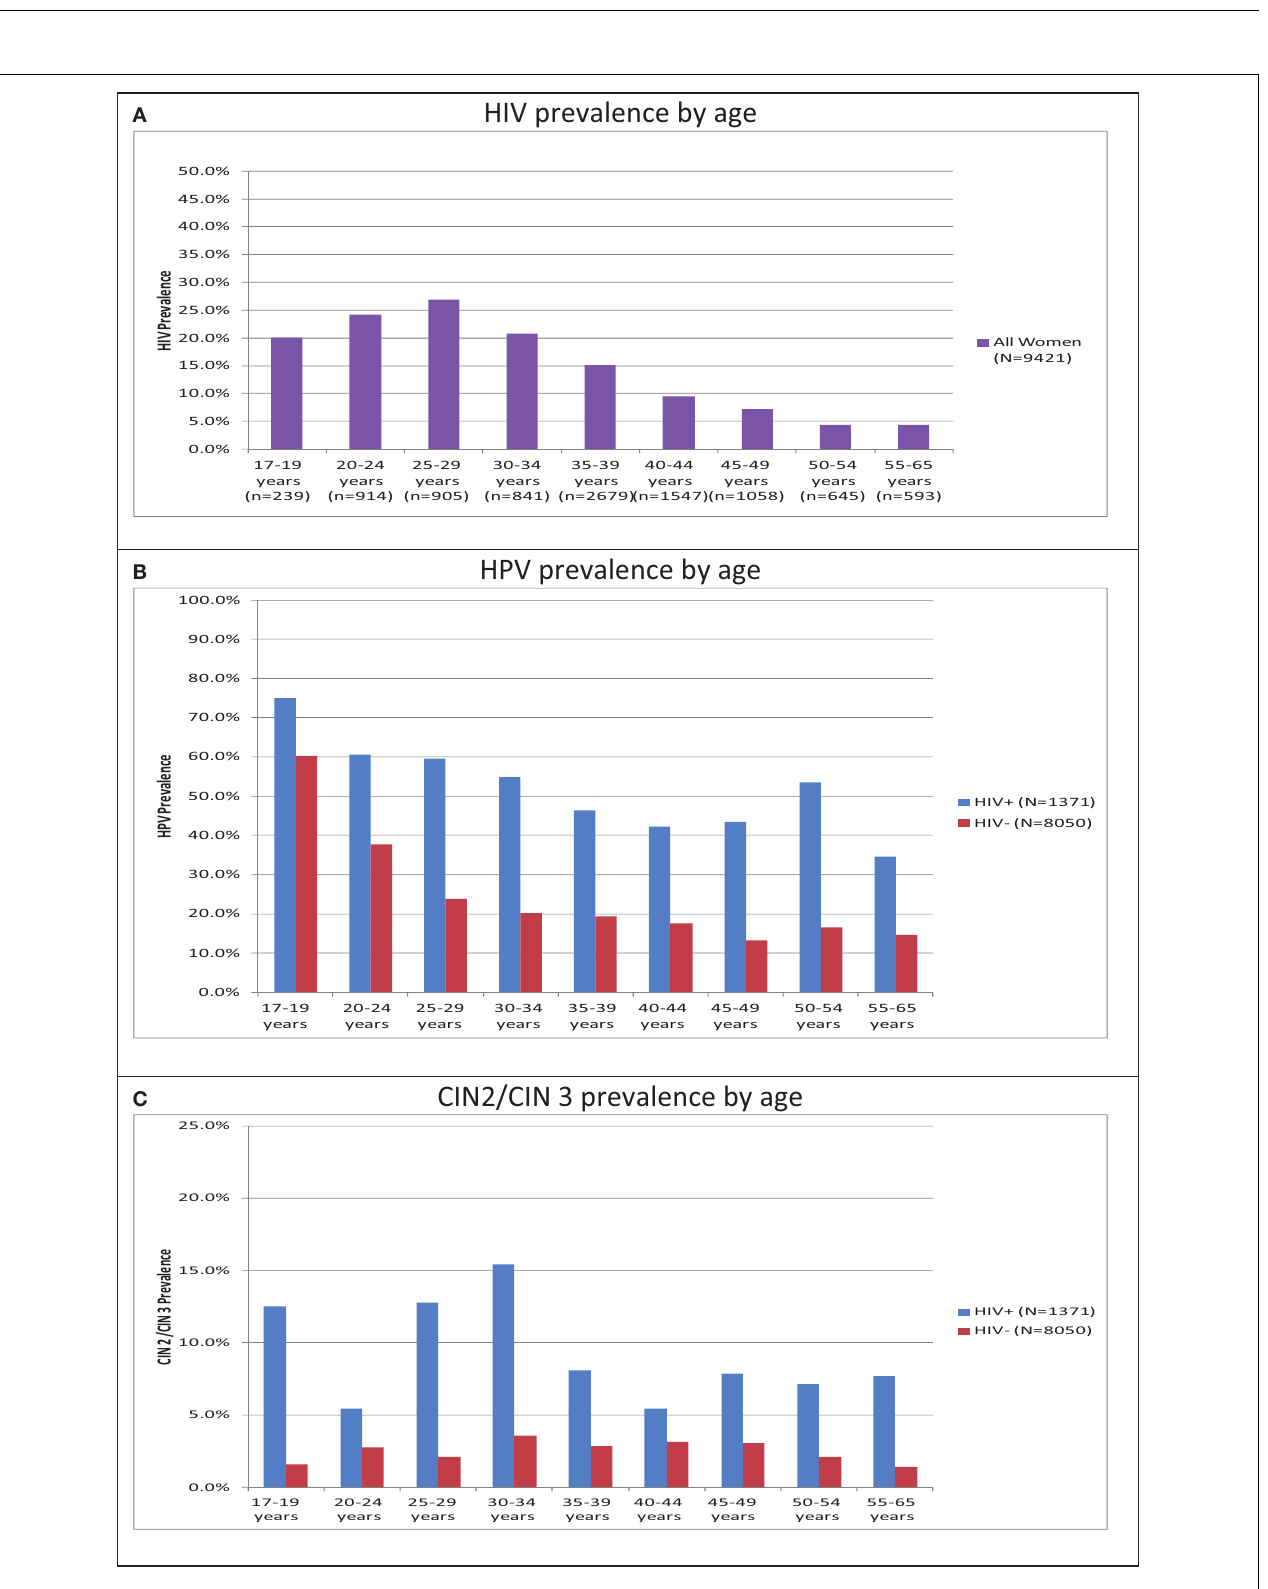
FIGURE 1 |Age-specific HIV, HPV, and cervical disease prevalence in 9,421 women recruited in CapeTown, SouthAfrica . (A) HIV prevalence by age. (B) HPV prevalence by age. (C) CIN2/CIN 3 prevalence by age. Note: CIN, cervical intraepithelial neoplasia; HPV, human papillomavirus. See Supplementary Material for